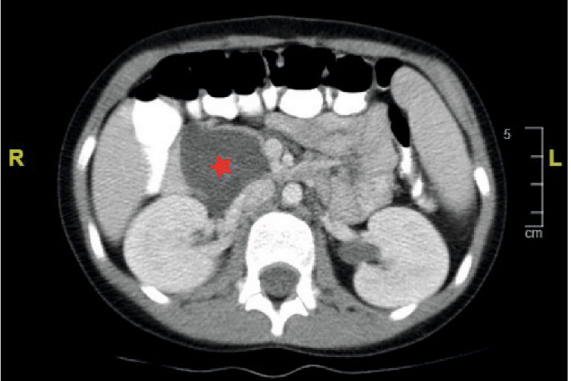
Figure 1: Computed tomographic scan of the abdomen revealed a large cystic lesion (star) in the region of pancreatic